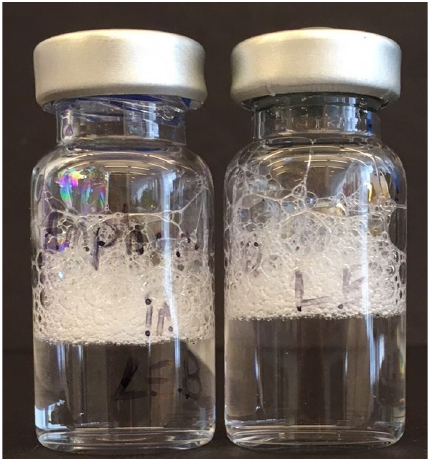
Fig. 1 Example showing photograph of stable solutions in brine at 100 °C for longer than one month. Samples were shaken to show that surfactant molecules are still present and did not decompose